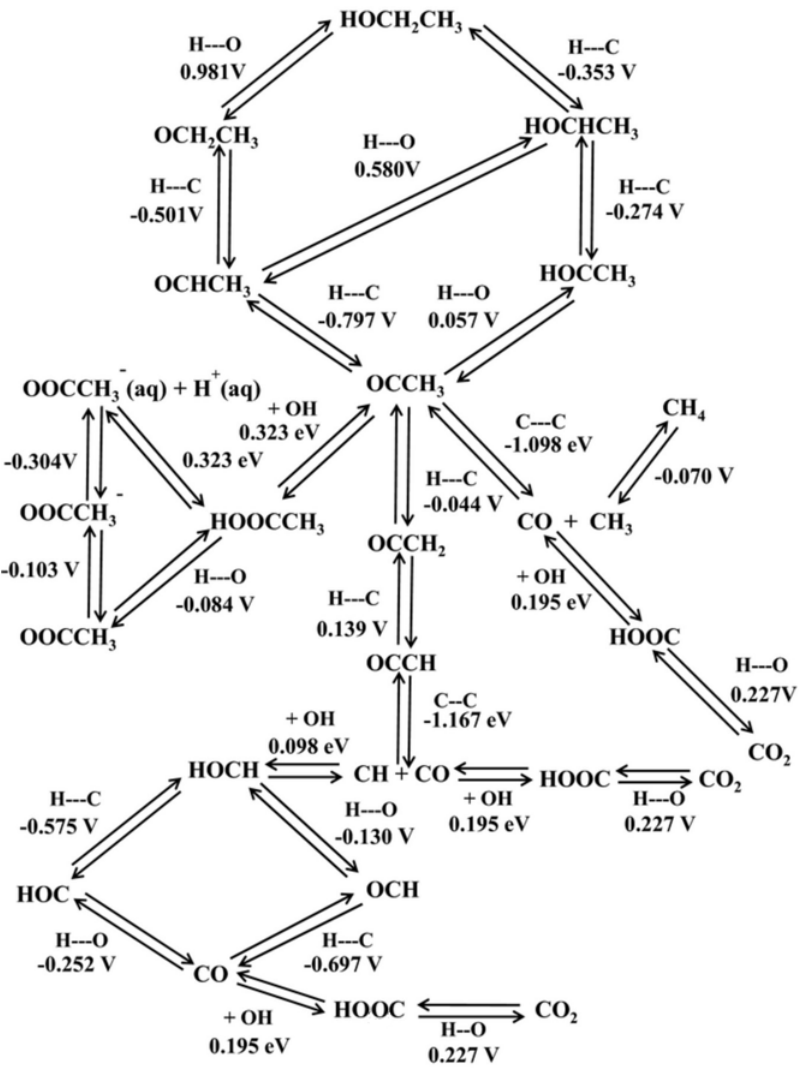
Figure 5. Reaction network calculated for ethanol electro-oxidation to CO 2 , methane, and acetate. Reproduced with permission from Reference [45]. Copyright 2015, the Electrochemical